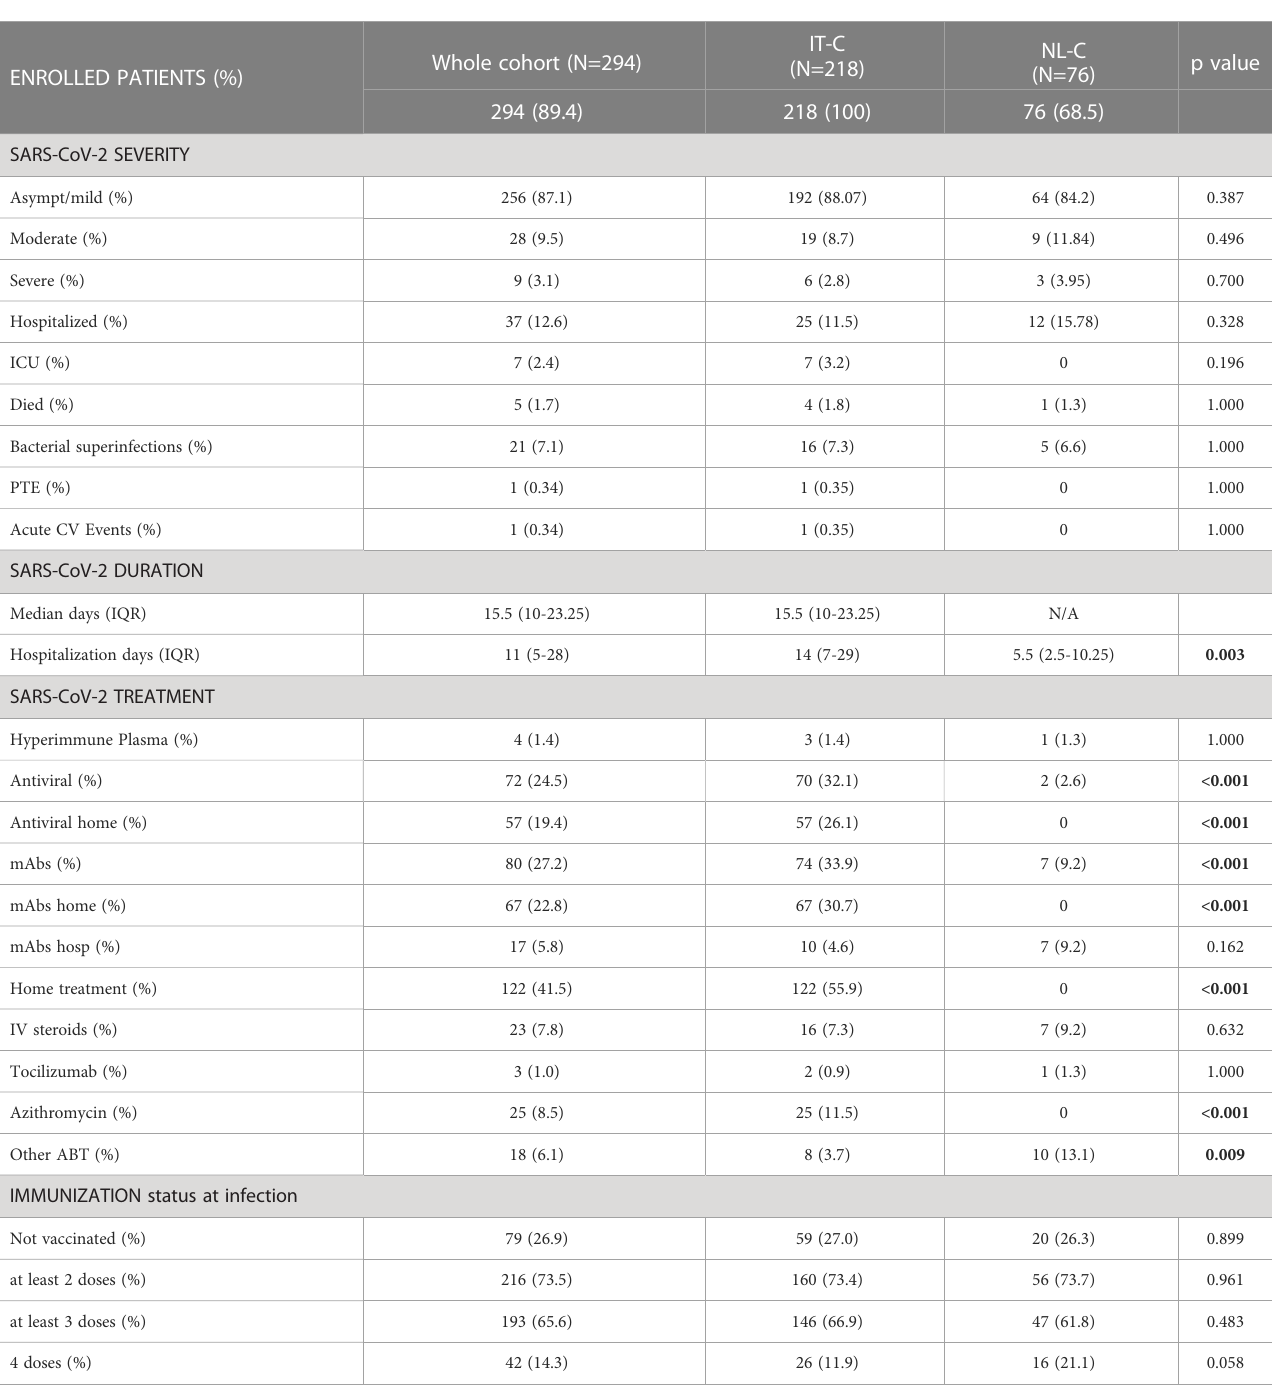
TABLE 2 COVID-19 course and